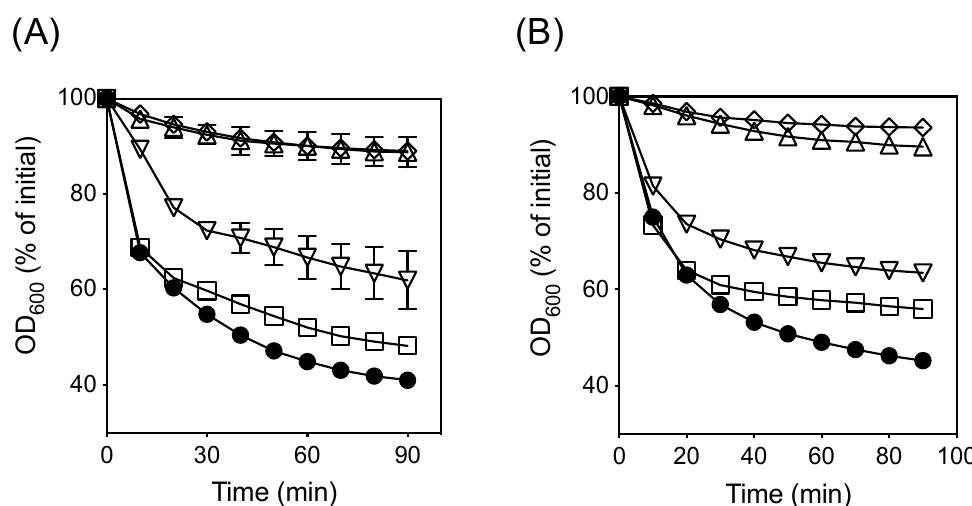
results were confirmed by using phase-contrast microscopy, ~ 90% of ∆ ytxC or ∆ yyaC2 spores remained phase bright after 90 min of incubation with 100 mM of KCl or L-cysteine in 25 mM Tris-HCl (pH 7.0) (data not shown). These results suggest that ytxC and yyaC2 are involved in C. perfringens spore germination. The spore germination defect in ∆ ytxC or ∆ yyaC2 mutant was restored to nearly wild-type level when complemented with the wild-type ytxC or yyaC2 gene, respectively (Figure 6A,B), further confirming that ytxC and yyaC2 are required for full germination of spores of C. perfringens.